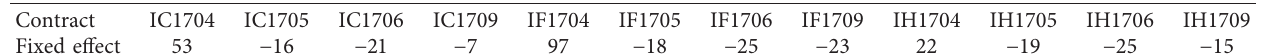
Table 4: Fixed effects of IC, IF, and IH contracts.